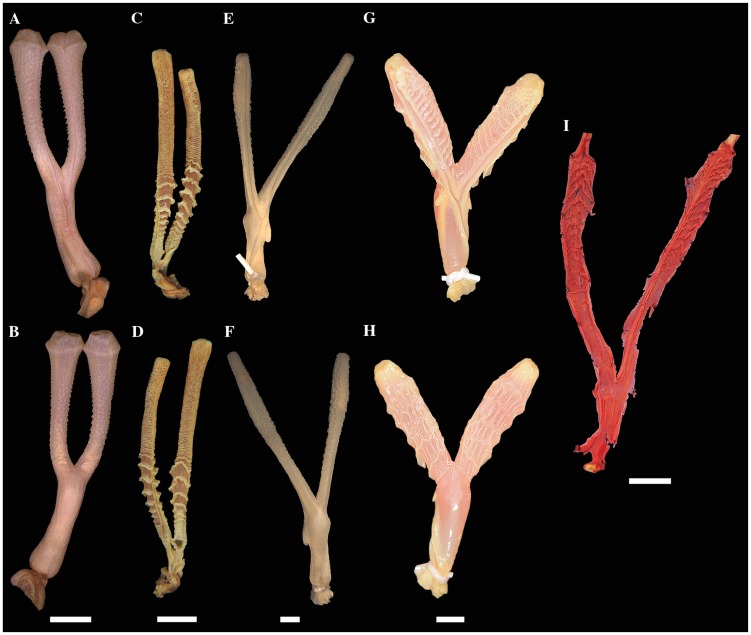
Hemipenes of Acrochordus javanicus (A-B),
Achalinus rufescens (C-D), Pareas
monticola (E-F), Asthenodipsas
malaccanus (G-H), and Xylophis
perroteti (I).A, C, E, G, sulcate views; B, D, F, H, asulcate views. A, B, E, F, G,
H, fully everted and expanded; C, D, fully everted and partially
expanded; I, opened through a longitudinal slit, spread flat, and
dyed with alizarin red. A-B, scale bar = 5 mm; C-D, scale bars = 2
mm; E-F, scale bar = 1 mm; G-H, scale bar = 1 mm; I, scale bar = 5
mm.